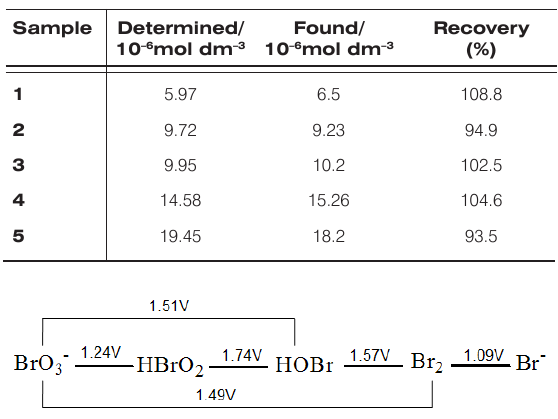
Table 2. Determination Results and Recovery of Vitamin B6 Tablets in Water Sample.